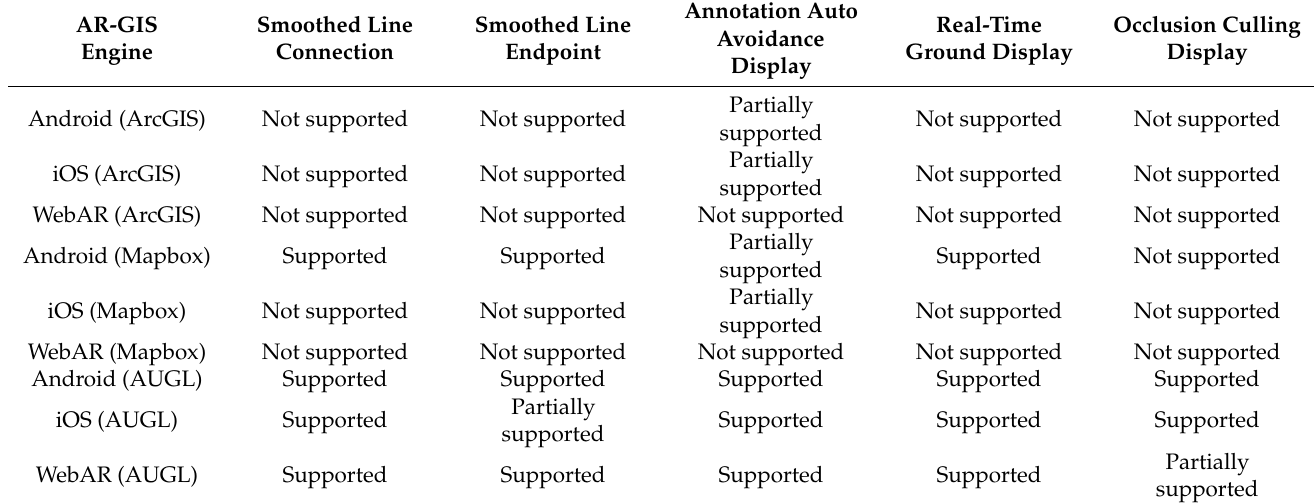
Table 3. Comparison of the consistency performance of three rendering engine drawing